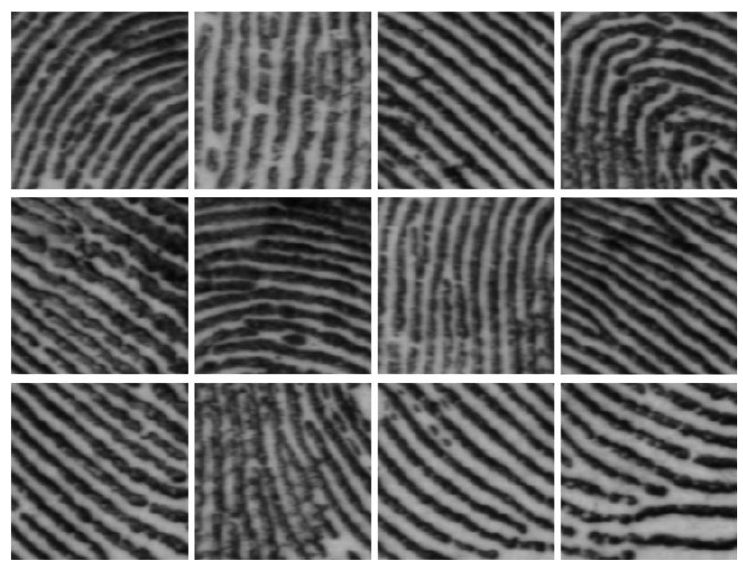
Figure 3. Example images in verification sets. The fingerprint image is evenly divided into local blocks with a size of 100 × 100.